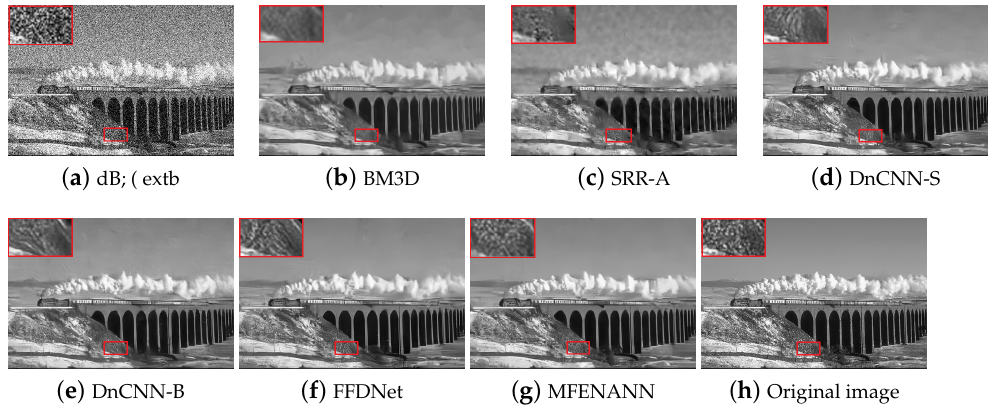
Figure 5. Experimental results of several state-of-the-art algorithms for image “test033” in “BSD68” at a noise level of 50. The PSNR values are: ( a ) noisy image, 14.69 dB; ( b ) BM3D, 23.64 dB; ( c ) SRR-A, 23.78 dB; ( d ) DnCNN-S, 24.81 dB; ( e ) DnCNN-B, 24.77 dB; ( f ) FFDNet, 24.86 dB; ( g ) MFENANN, 24.93